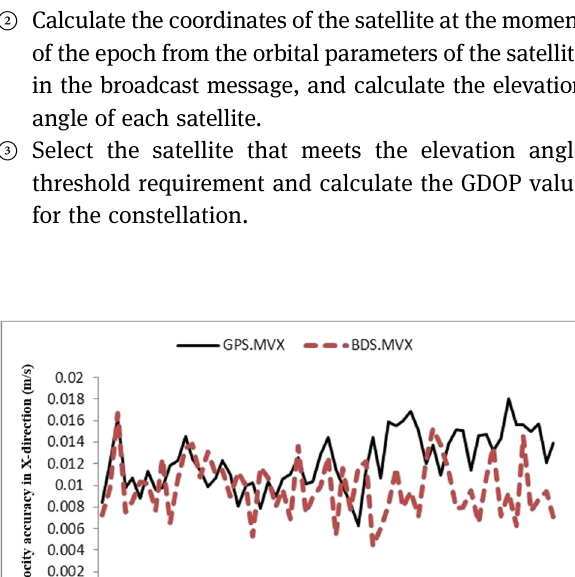
Figure 6: Position precision of on - board BDS and GPS in Z - direction.